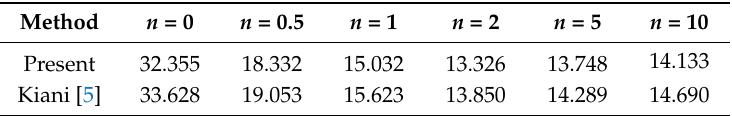
Table 7. Critical buckling temperature ∆ T cr of CCCC type-II FGM rectangular plate under a uniform temperature field ( a / h = 100, a / b =